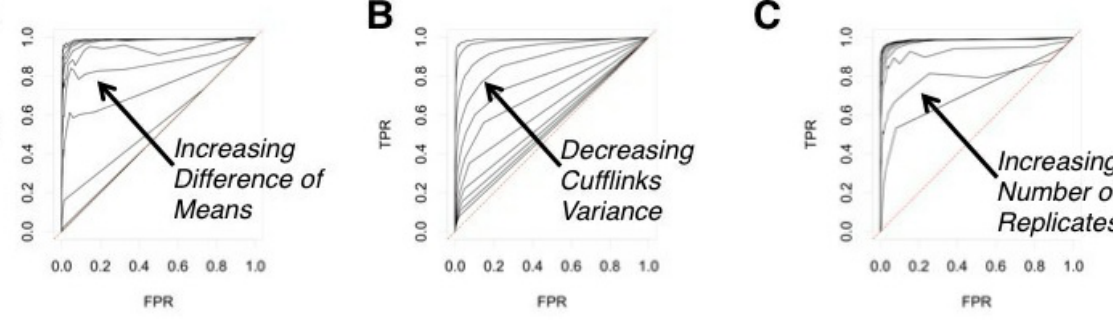
2.5. Generating an RNA-Seq Benchmark Dataset for Comparing Various Differential Expression Testing